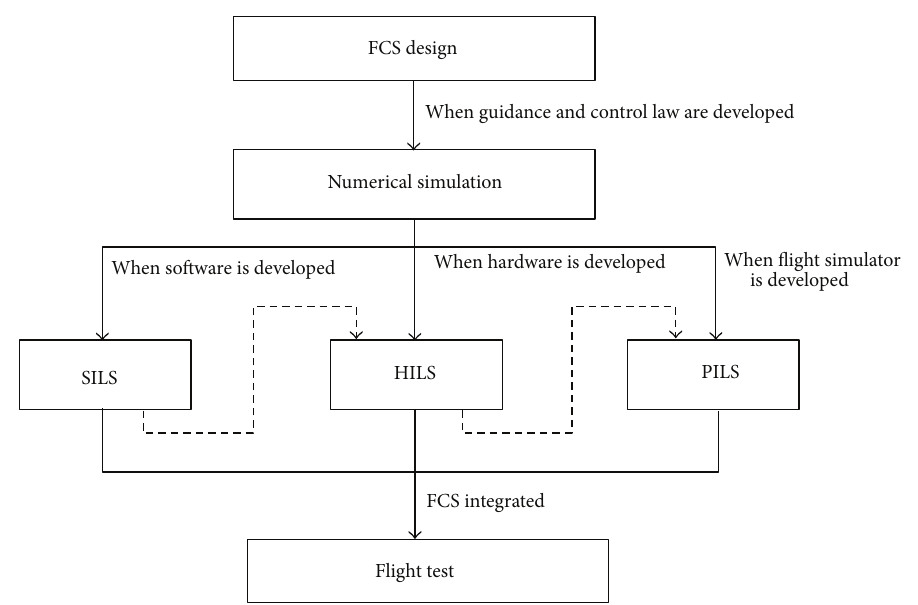
Figure 9: Methods for evaluating FCS in different development